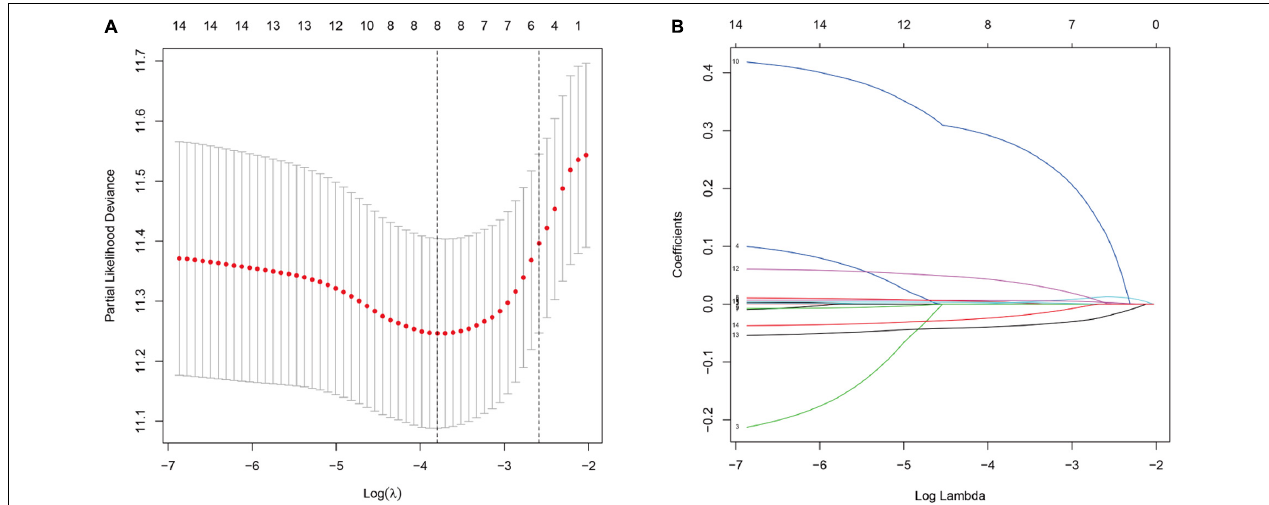
FIGURE 2 | (A) Partial likelihood deviance versus log ( λ ) was performed through LASSO regression. (B) Coefficients of selected features are shown by lambda